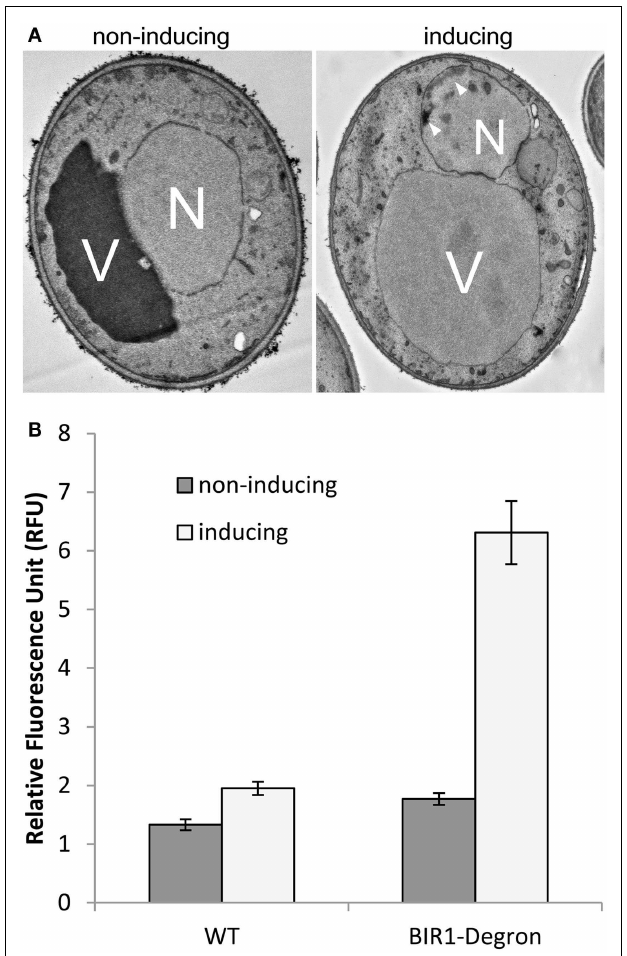
FIGURE 3 | Bir1 deletion causes apoptotic cell death. (A). TEM images showing bir1 deletion caused chromatin condensation (arrowheads) in